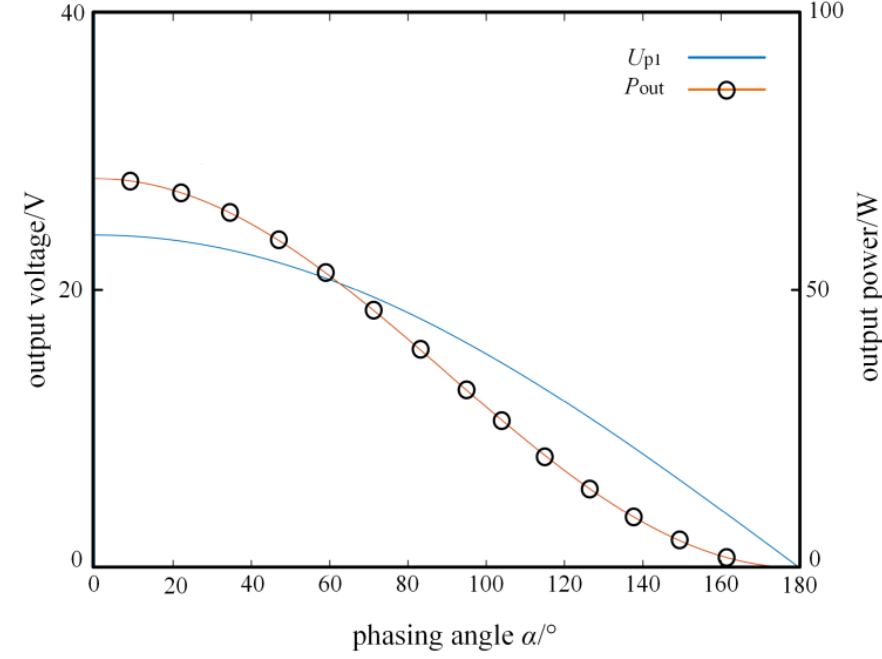
Figure 5. Voltage, power and phase diagram. Table 1. Experimental parameters.